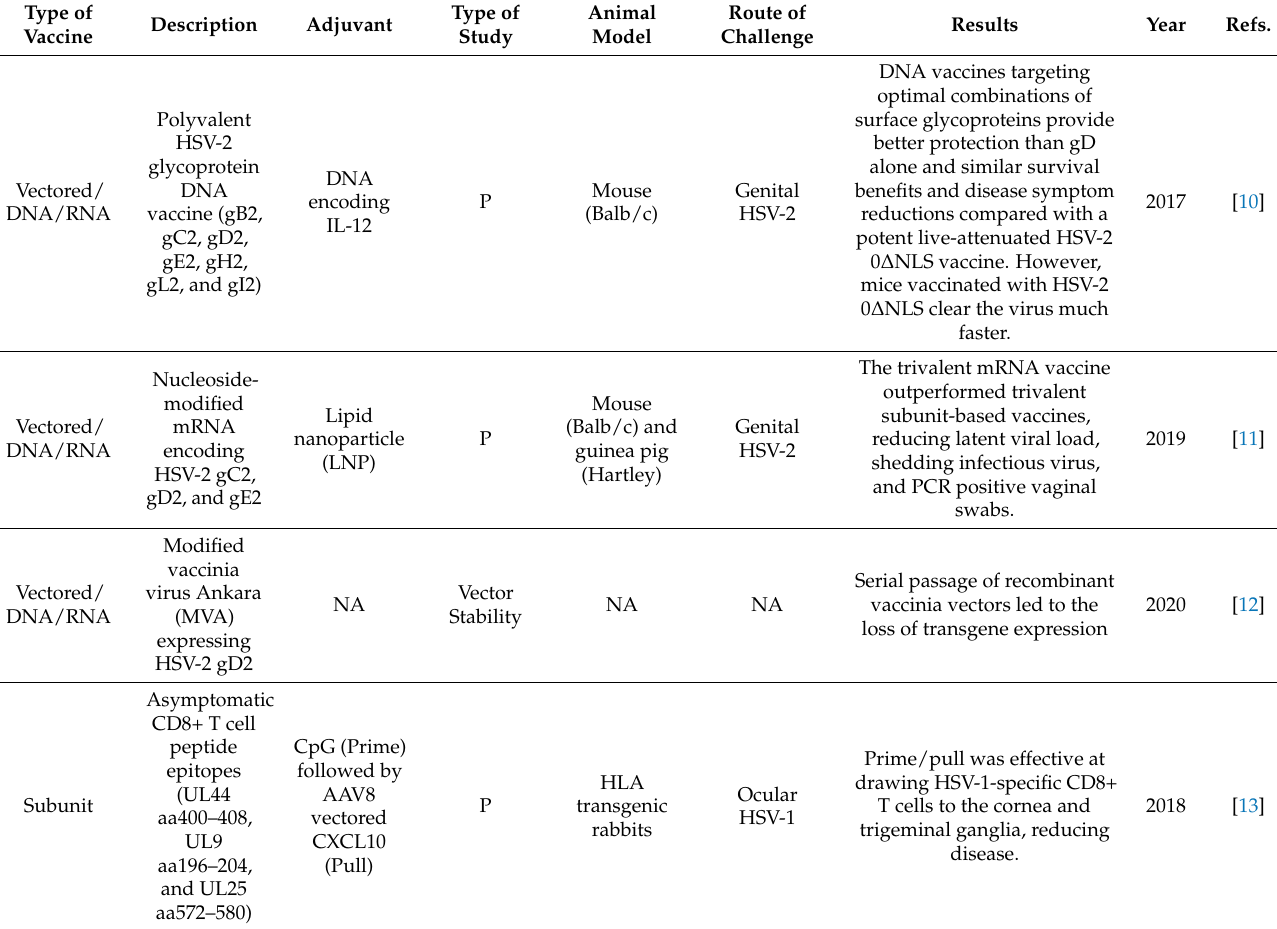
Table 1. Current herpes simplex vaccines under preclinical